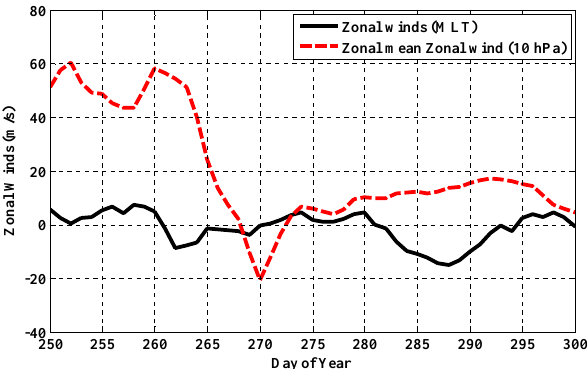
Fig. 4. Zonal wind evolution in the MLT region (~94 km) obtained by SANAE HF radar (solid black line) during the period from 250 to 300 2002-Julian days. The red dashed line illustrates the zonal-mean zonal wind variation at 10 hPa (32 km) derived from NCEP reanalyses at 60° S for the same period of time.